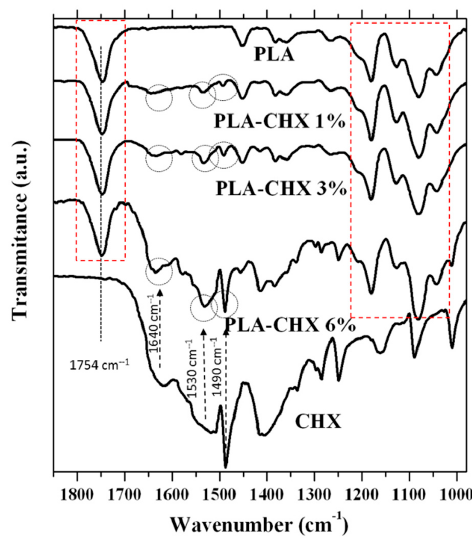
Figure 5. Infrared absorption spectra of PLA, PLA samples loaded with different amounts of chlorhexidine (CHX) and pure CHX. Dashed red boxes indicated bands associated with PLA. GPC curves were recorded for specimens loaded with di ff erent percentages of TCS and CHX and processed under the conditions optimized for the PLA matrix (24 µ m-300 N-1.2 s). In this way,